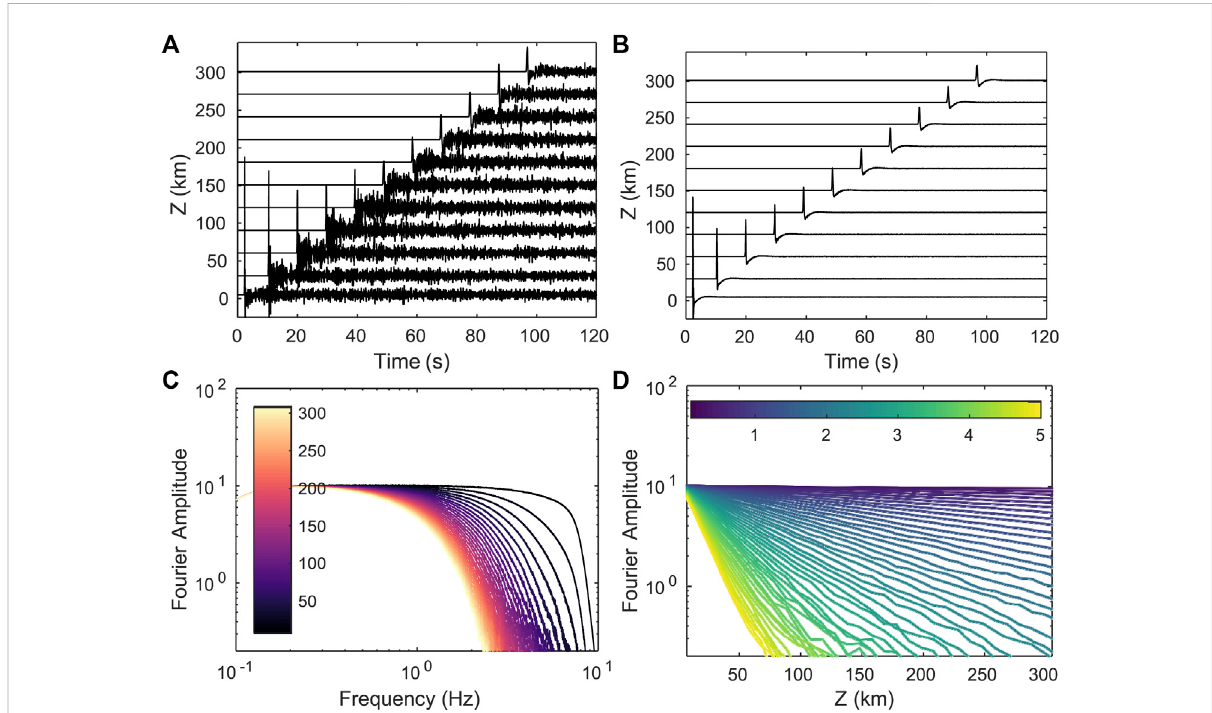
FIGURE 4 Waveforms and Fourier spectra for the case ] = 1 and ε = 5%. Top: seismic sections of particle velocity for one single realization (A) and for the coherentwave fi eldobtainedbyensemble-spaceaverage (B) Bottom:Fourieramplitudespectraofthecoherentwave fi eldasafunctionoffrequency (C) and source-receiver distance (D) Color bars represent the range of propagation distance and frequency, respectively.